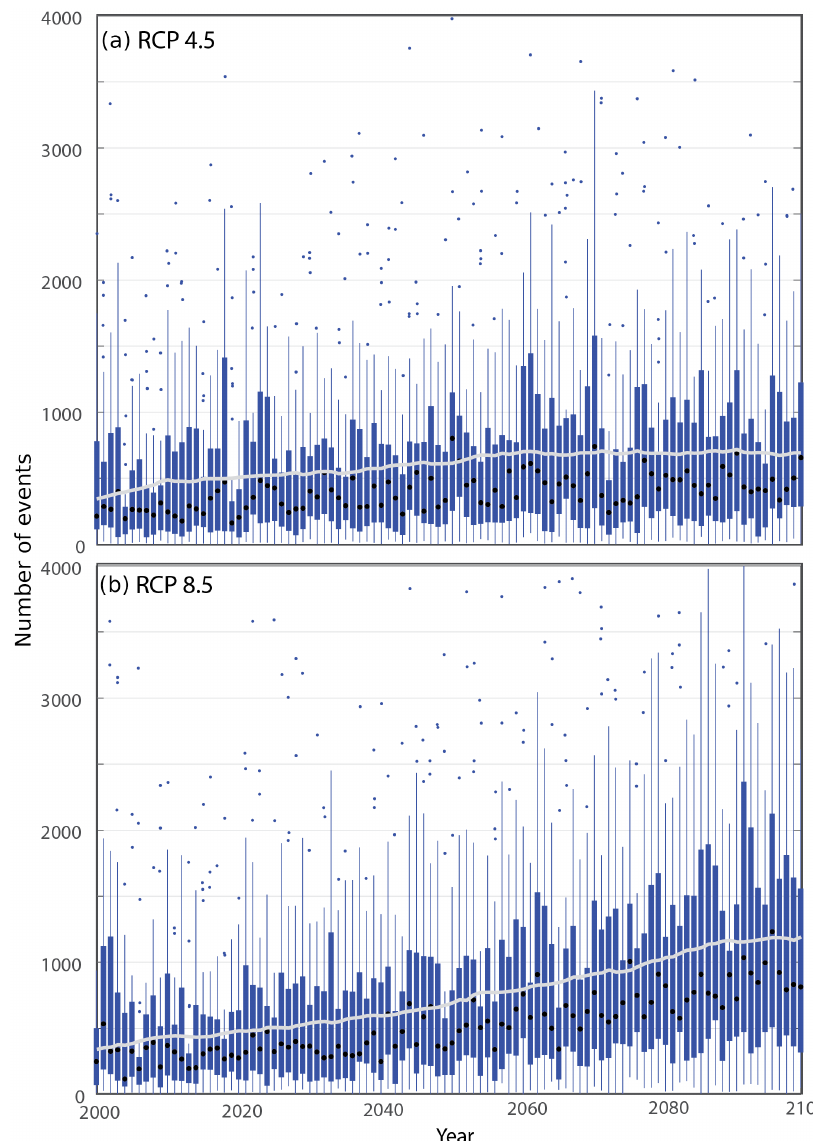
Figure 5. Number of floods throughout the CONUS in each year of the 21st century across all 29 GCMs in (a) RCP 4.5 and (b) RCP 8.5. In each plot, black dots are the median value across all 29 GCMs, thick blue bars are the middle 50% of models, whiskers extend to the 95th percentile of values, and dots represent outliers. The thick grey line is the 5-year moving mean across all models. Light grey shading in the background shows the period used to calculate the baseline 1% AEP